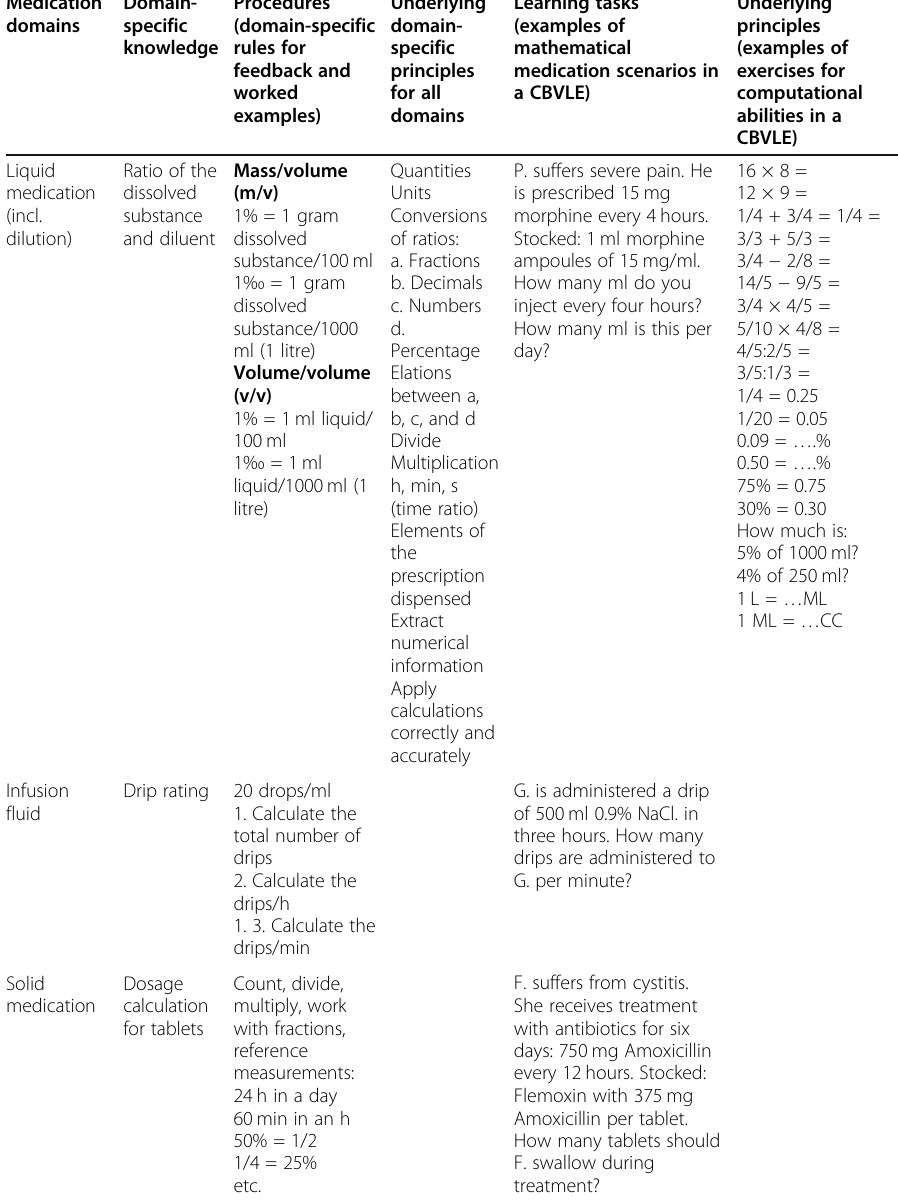
Table 1 Aspects of domain-specific mathematical knowledge related to ‘ liquid medication ’ , ‘ infusion fluid ’ , and ‘ solid medication ’ in a